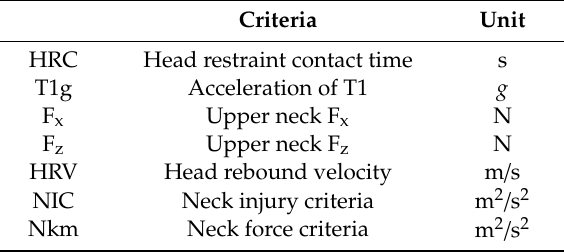
Table 2. Whiplash assessment criteria.